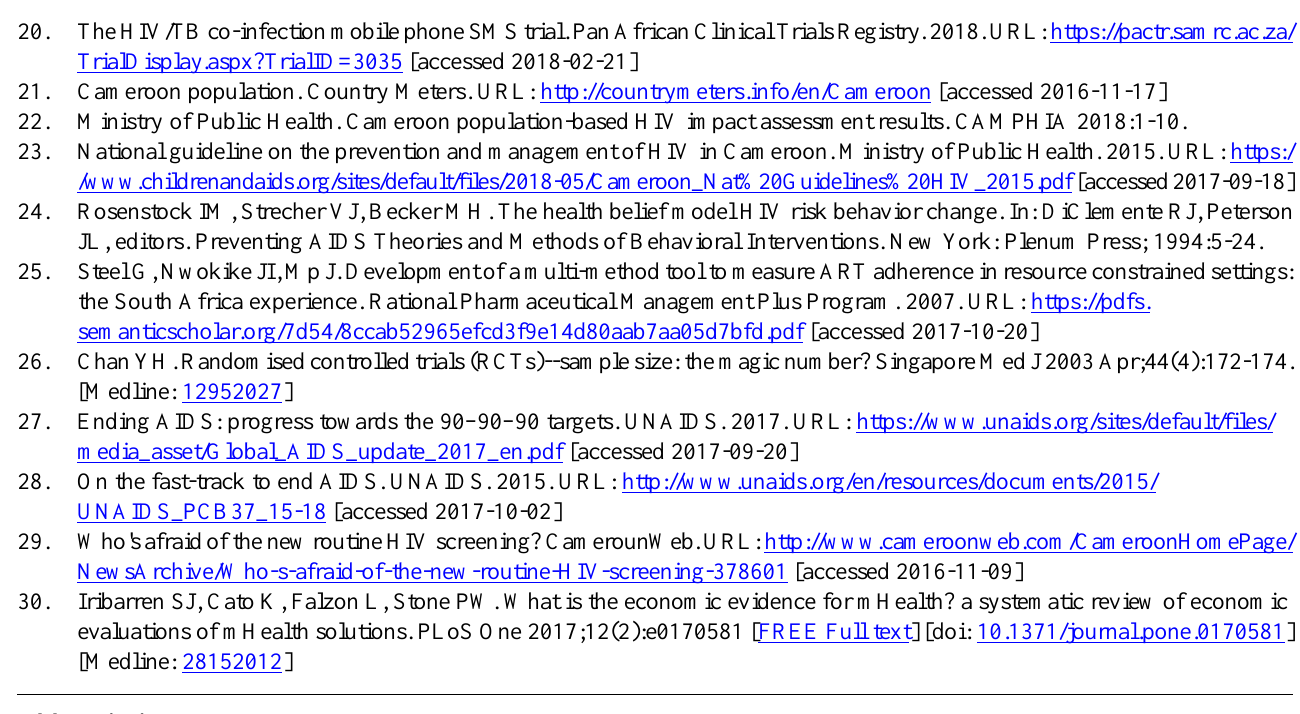
Abbreviations ART: antiretroviral therapy CONSORT: Consolidated Standards of Reporting